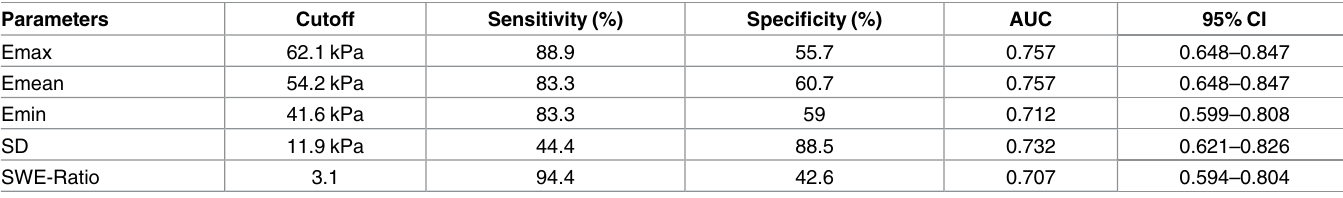
Table 4. Diagnostic performances of shear-wave elastography for differentiating between benign and atypical or malignant papillary lesions.